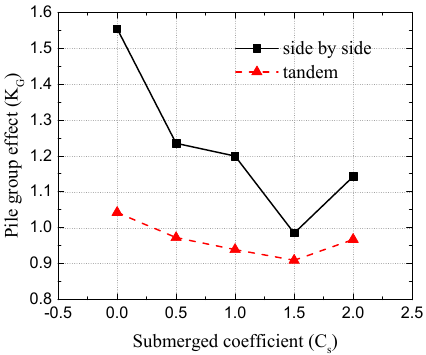
Figure 10. Variations of the pile group effect versus various submerged coefficients of the cap with different arrangements of the pile group. different arrangements of the pile